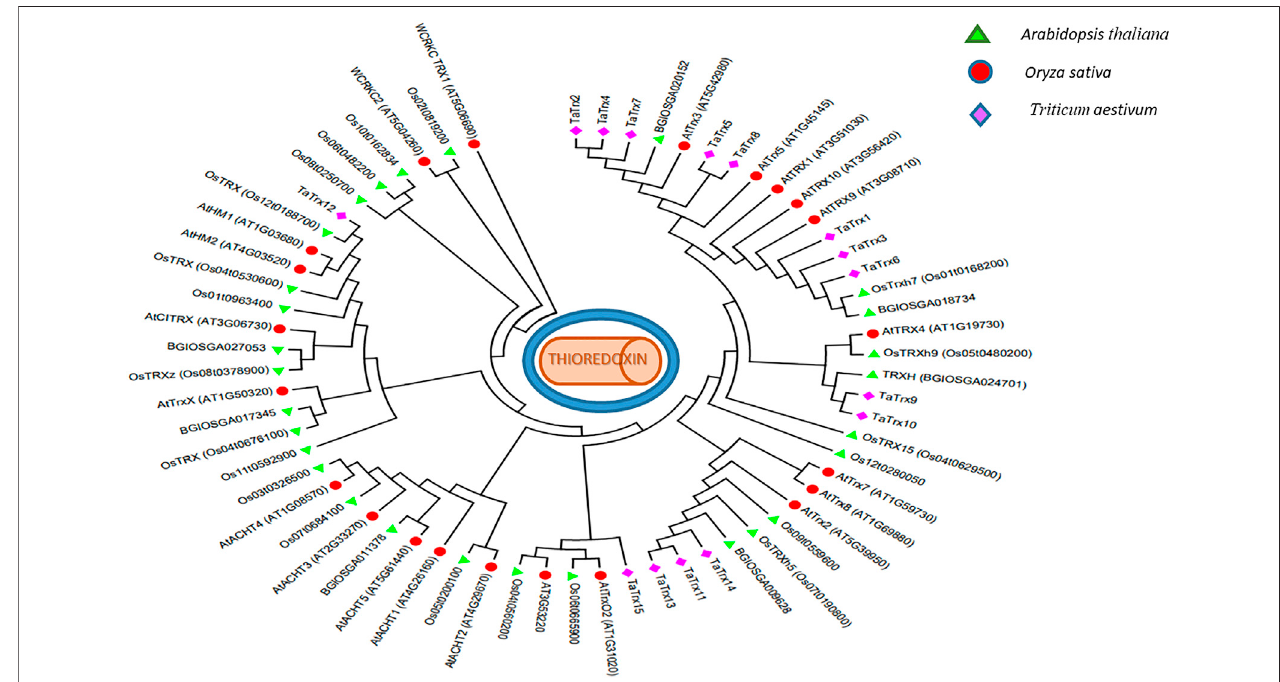
FIGURE 4 | Phylogenetic tree constructed using MEGA X (v7) software (https://www.megasoftware.net/) of the identi fi ed wheat TaTrx protein along with Arabidopsis and rice Trxs.